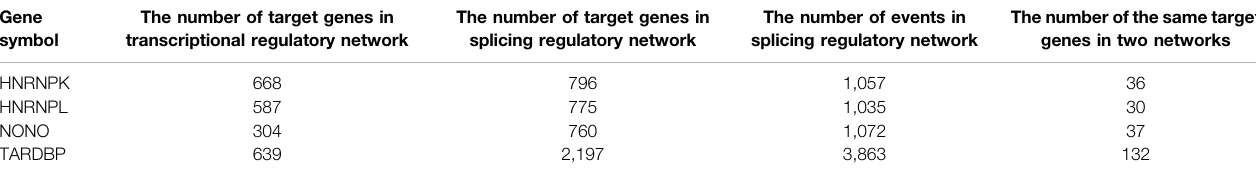
TABLE 2 | Target gene number of two-layer regulatory networks associated with HNRNPK, HNRNPL, NONO, and TARDBP. Gene symbol